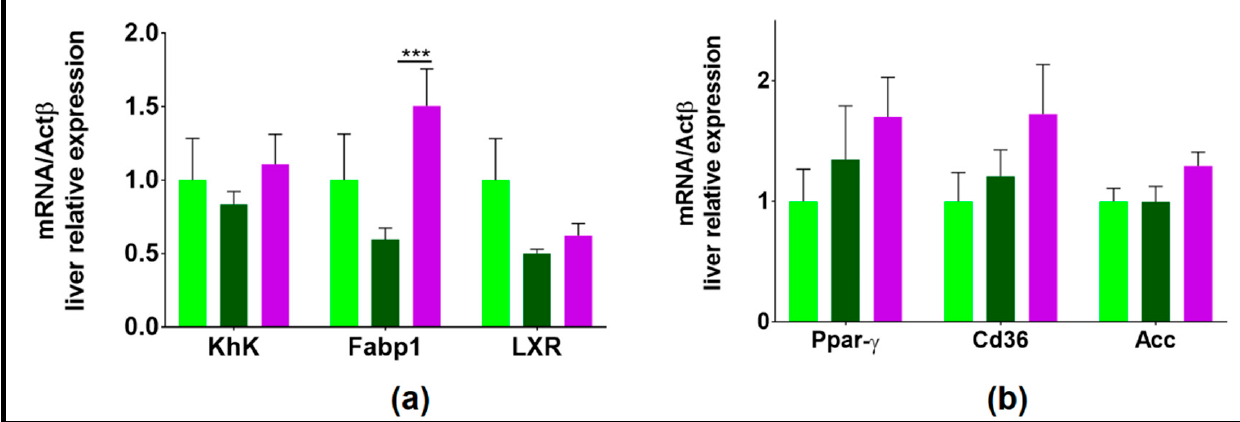
Figure 9. Hepatic expression of genes involved in lipid and carbohydrate metabolisms. ( a ) genes whose expression tended to decrease with 2HFD and then tended to increase with NAFL microbiota ( b ) genes whose expression tended to increase with 2HFD and even more with NAFL microbiota; HR, healthy human microbiota receiver mice; CD, control diet; 2HFD, high-fructose, high-fat diet; NAFLR, NAFL patient microbiota receiver mice; light green, HR_CD, HR mice on CD; dark green, HR_2HFD, HR mice on 2HFD; purple, NAFLR_2HFD, NAFLR mice on 2HFD; (*** p < 0.001) was used for statistical comparisons.